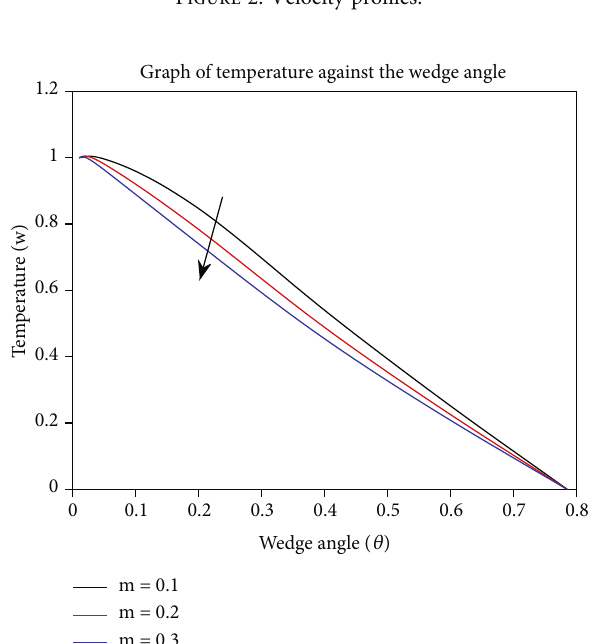
Figure 2: Velocity pro fi les.